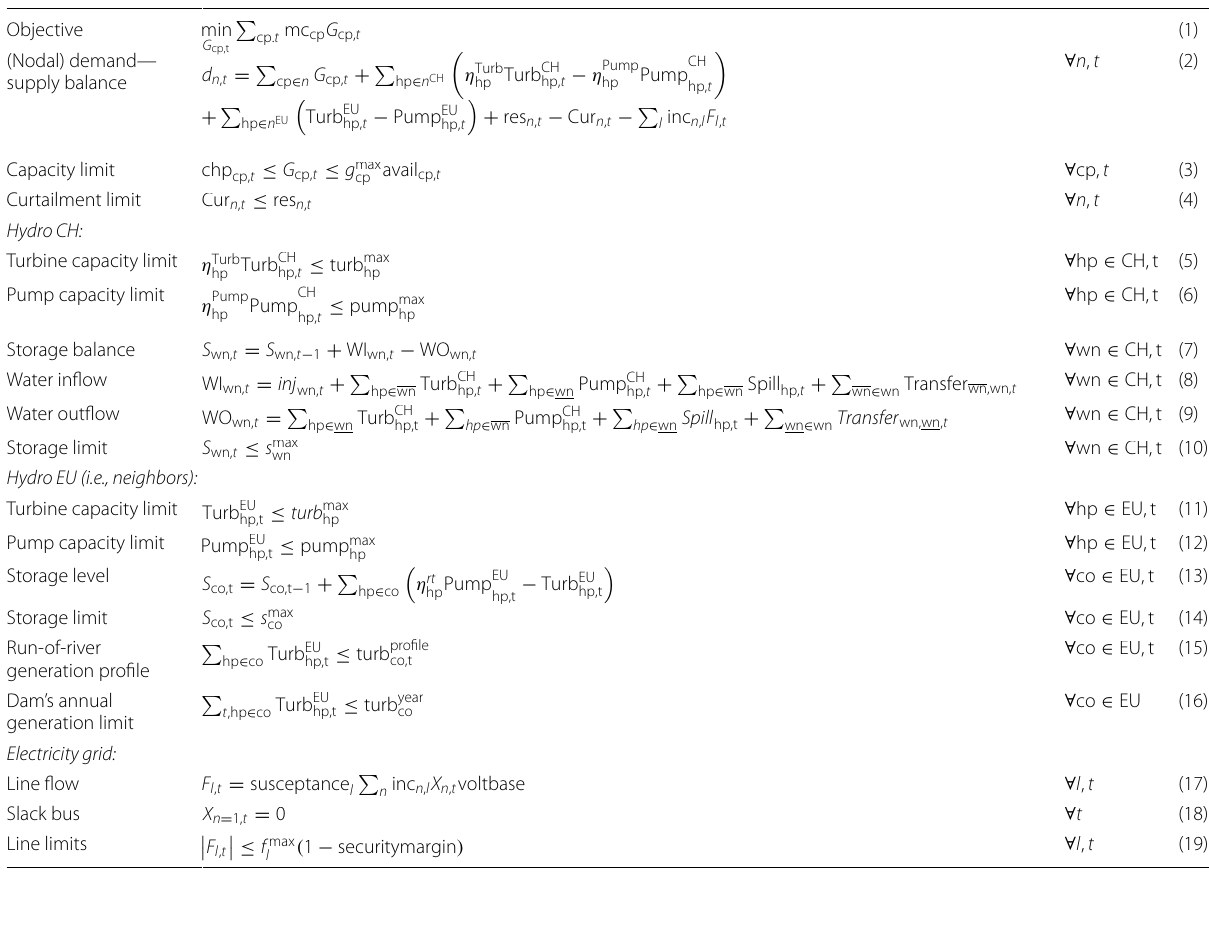
Table 7 Mathematical formulation of the Swissmod model